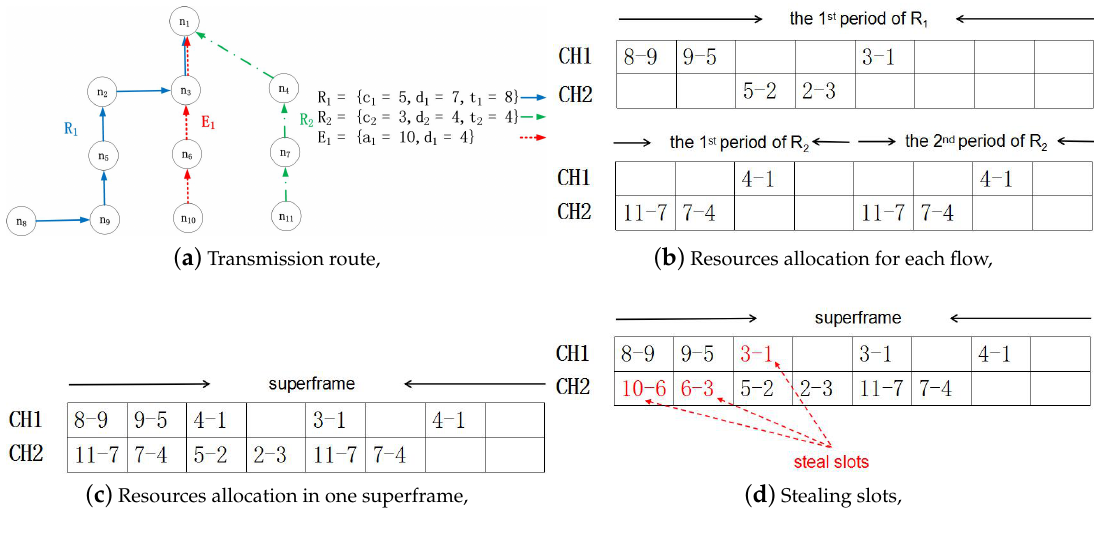
Figure 2. An example of the stealing